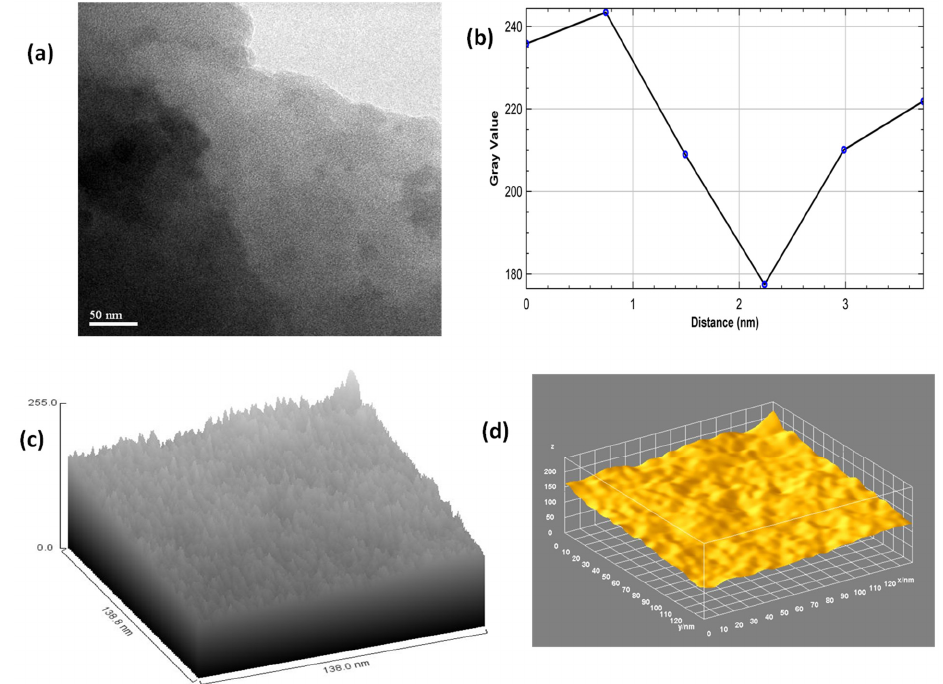
Figure 4. ( a ) TEM image of GO, ( b ) Plot profile diagram from the TEM image of GO, ( c ) Hill stack plot from the TEM image of GO, ( d ) 3D surface plot from the TEM image of GO. The 3D surface morphology of the GO sheets from the TEM image depicts the pres-